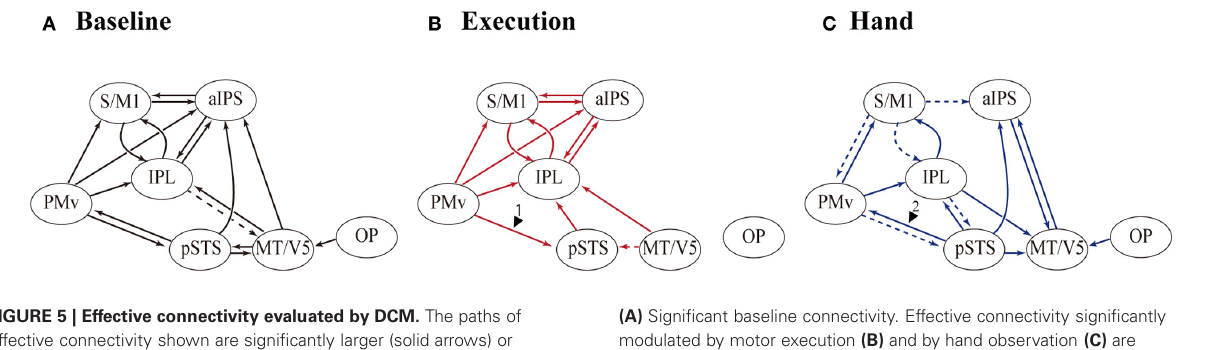
(A) Significant baseline connectivity. Effective connectivity significantly modulated by motor execution (B) and by hand observation (C) are